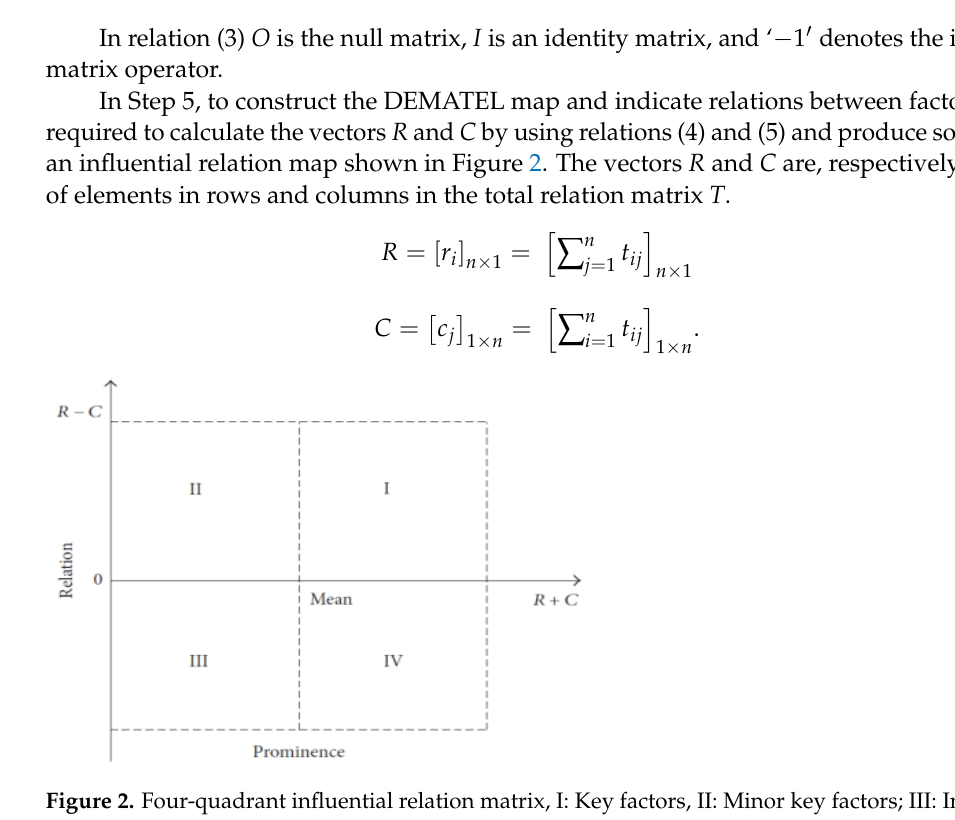
Figure 3. Weight of criterion C j (adapted from [5]). R+C